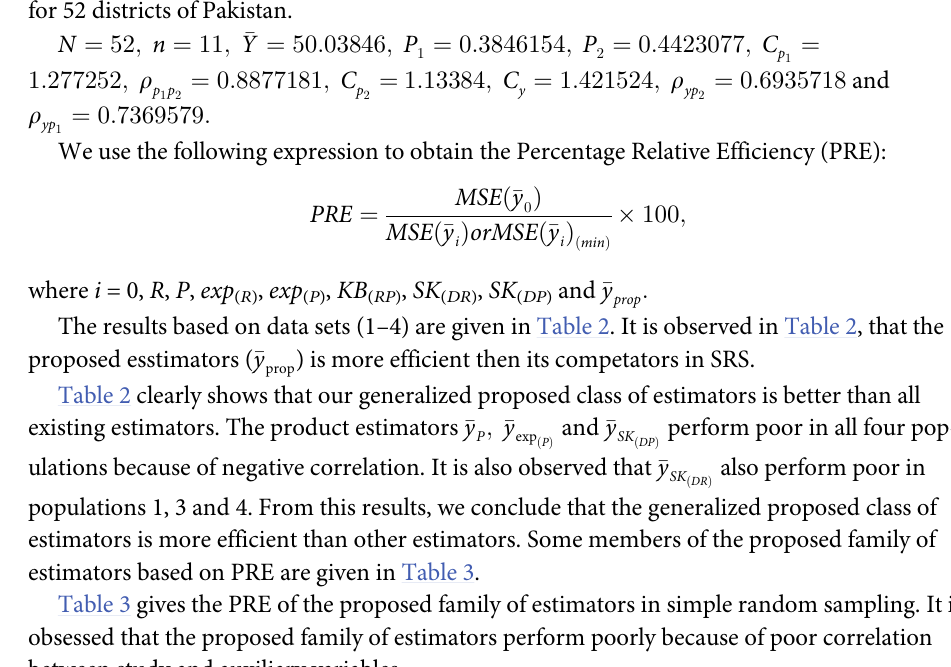
Table 2. Percentage relative efficiency (PRE) with � y